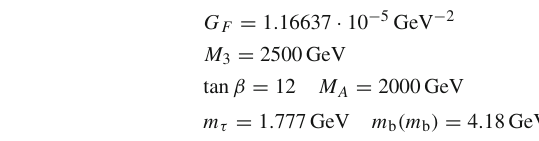
(the other A f are set to zero), the sfermion mass sfermion term A f 3 1 , 2 m ¯ and also the pseudoscalar Higgs mass input M f L , ¯ f R